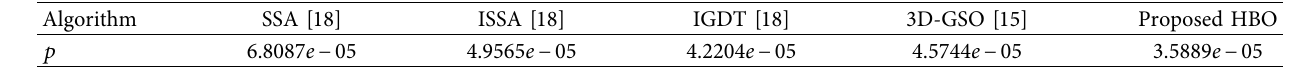
Table 9: Te Wilcoxon test probability for diferent algorithms. Algorithm